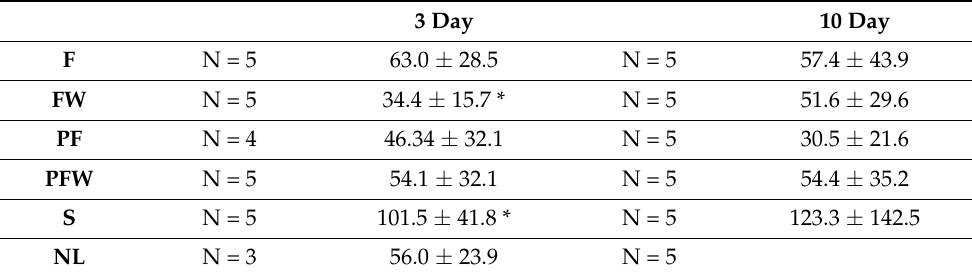
Table 1. Elastic modulus (PSI)